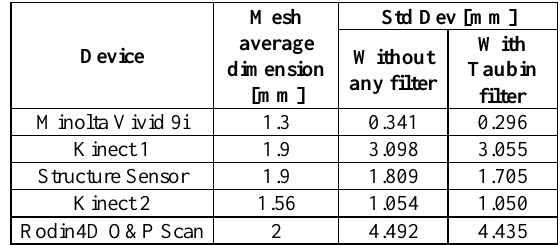
Table 3. Values of mesh size and standard deviation of the cloud to mesh distance for the flat plane models before and after the application of the Taubin filter.